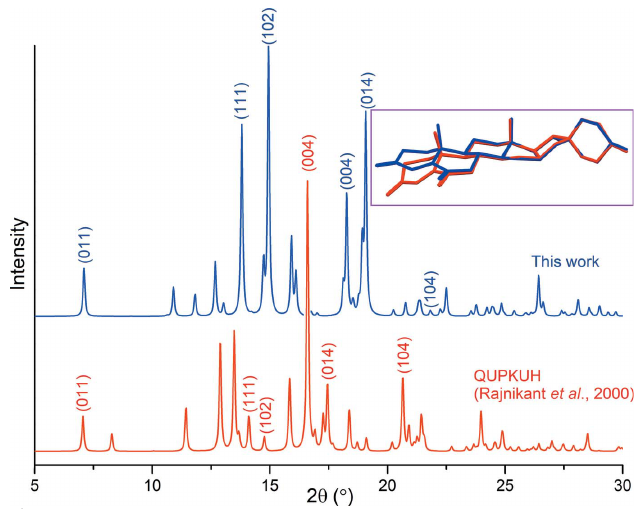
Figure 2 Simulated powder patterns (Macrae et al. , 2020) for the two P 2 1 2 1 2 1 polymorphs of the title compound, with (cid:3) = 1.54 A˚ . Some reflections are indexed, in order to illustrate reflection shifts and intensity variations between both polymorphs. The inset shows an overlay between molecular structures, obtained by fitting C and O atoms in rings C / D / E / F . In the case of QUPKUH (Rajnikant et al. , 2000), coordinates deposited in the CSD were inverted, and H atoms were placed in idealized positions.